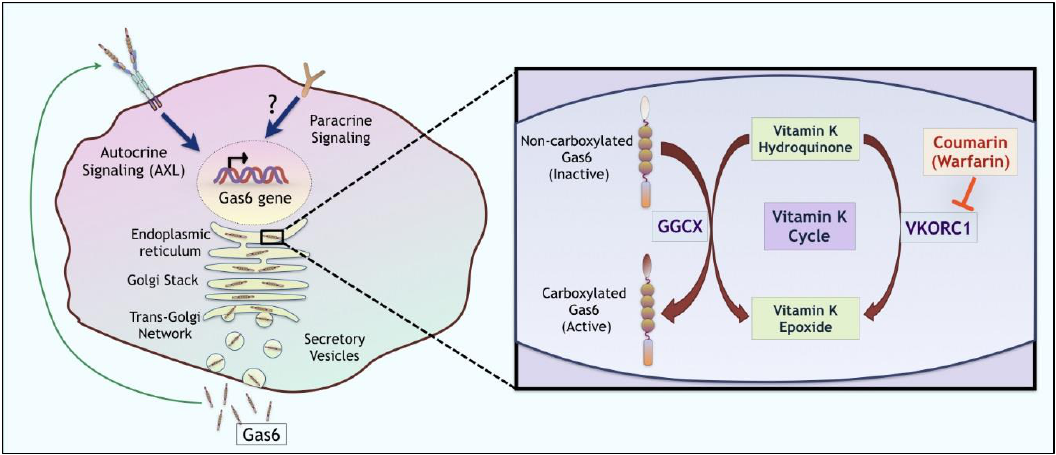
Figure 2. Post-translational modifications of Gas6 by γ-glutamyl carboxylation. Gas6 can be transcriptionally upregulated by autocrine or paracrine mechanisms. Following translation, un- carboxylated Gas6 (inactive) is activated by a series of enzymatic steps involving γ-glutamyl carboxylation via the vitamin-K-dependent enzyme γ-glutamyl carboxylase (Ggcx). The carboxylated (active) Gas6 from ER is transported to the Golgi apparatus through trans-Golgi network and then into secretory vesicles. The Vit-K epoxide reductase enzyme complex 1 (Vkorc1) then completes the